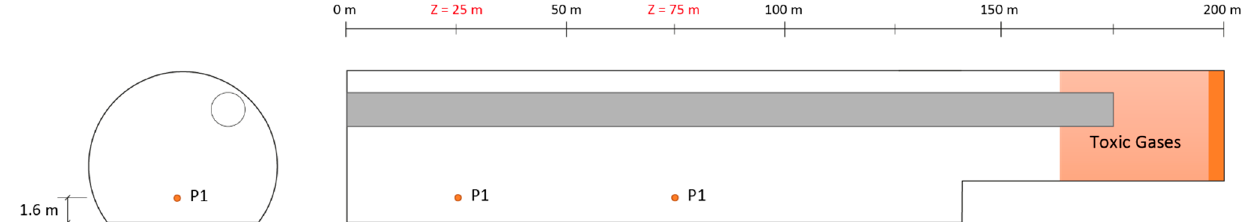
Figure 8. Location of the measuring points (P1) at the height of the human breathing zone (Y = 1.6 m) at the cross sections of Z = 25 and Z = 75 m.